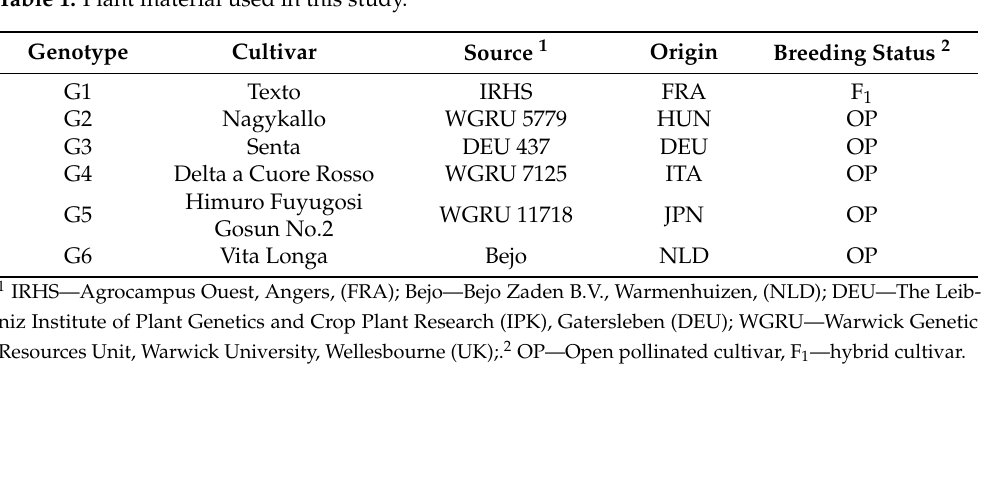
Table 1. Plant material used in this